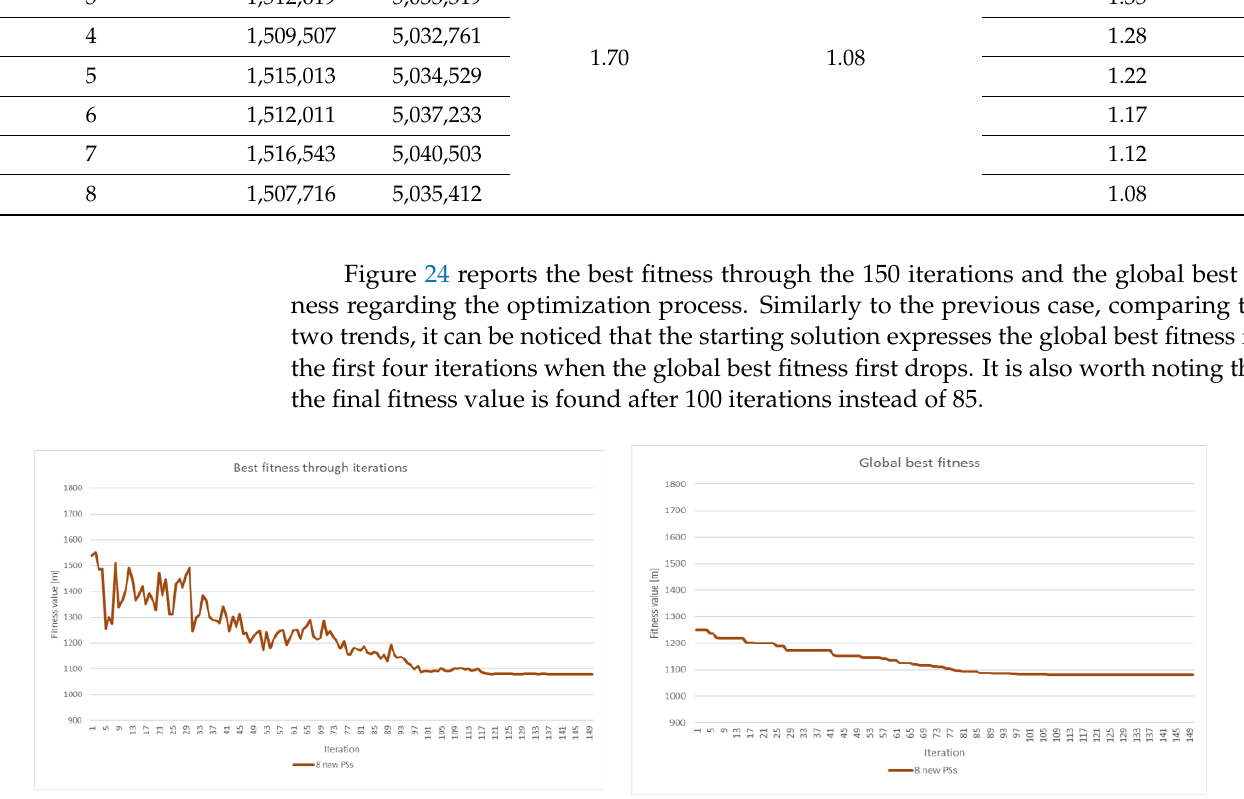
Figure 25. Output of the simulation results considering eleven new PSs. Yellow points are the new PSs, while gray is the existing ones. The PSs service areas are highlighted in Figure 26. The increased number of new PSs allowed reducing the PS service areas dimension again, giving undoubted advantages in reducing the distance between squares and the related PSs. Even in this case, the cells ’ colors show that the algorithm does not fail to find a feasible solution, which guarantees a power demand of the PSs lower than 75% of the transformers ’ nominal power. Never- theless, one PS has a loading greater than 50%, but just a little to have enough capacity to face additional future load increases.